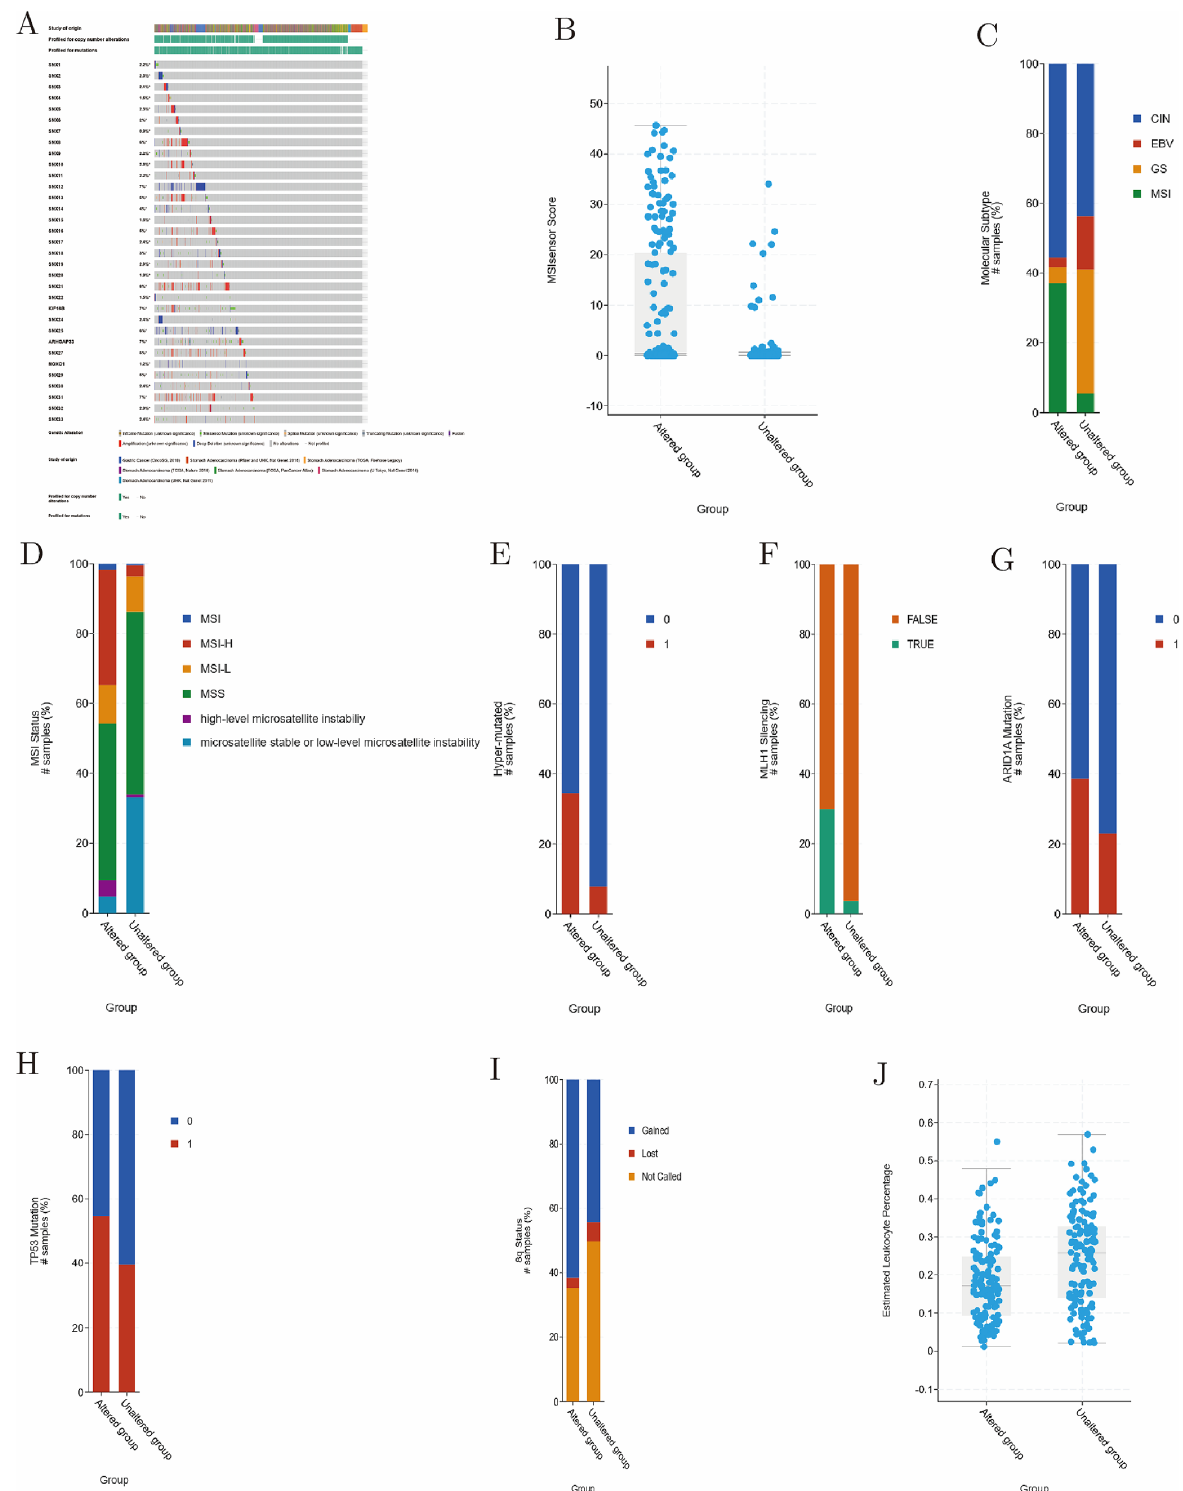
Figure 6. Effects of alteration of SNX family determined with cBioportal. ( A ) Alteration frequency of SNX family in GC, with 700 out of 1512 mutated. SNX family alteration contributing to MSI ( B–C ), high level of MSI ( D–E ), methylation of MLH1( F ), mutation of tumor suppressing genes ( G–H ), gain of 8q ( I) , and alleviation of tumor immune infiltration ( J